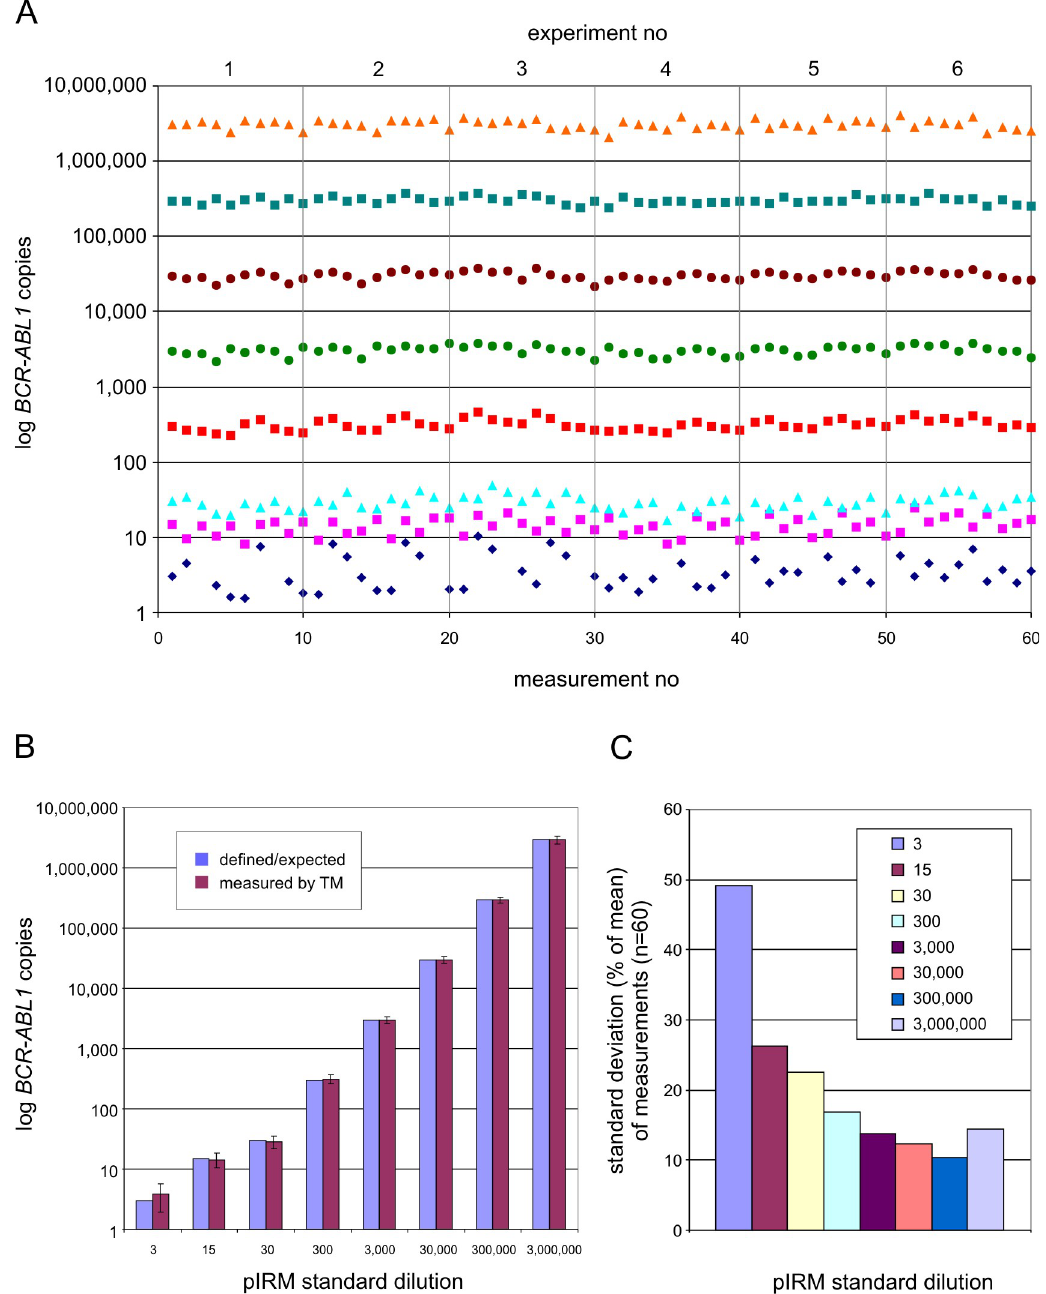
Fig 1. Diagnostic accuracy. Assessment of inter- and intraexperimental accuracy by TM PCR using pIRM standard dilutions representing 3–3,000,000 plasmid molecules per assay. (A) Six independent experiments with 10 replicates each revealed 60 consecutive data points for each of the 8 standard dilutions as depicted by the symbols in horizontal order. (B) Calculated variance of standard dilution measurements with regard to the defined/expected plasmid molecule numbers as theoretically deployed in the assay. (C) Standard deviation (in % of mean) of measurements shown in (A).